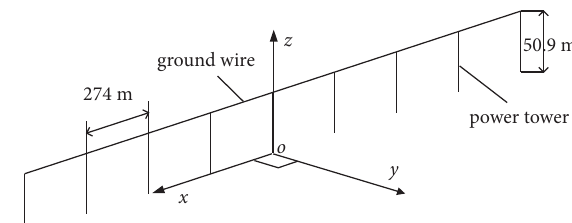
Figure 4: Model for calculation of induced current on PTL below 1.7 MHz.